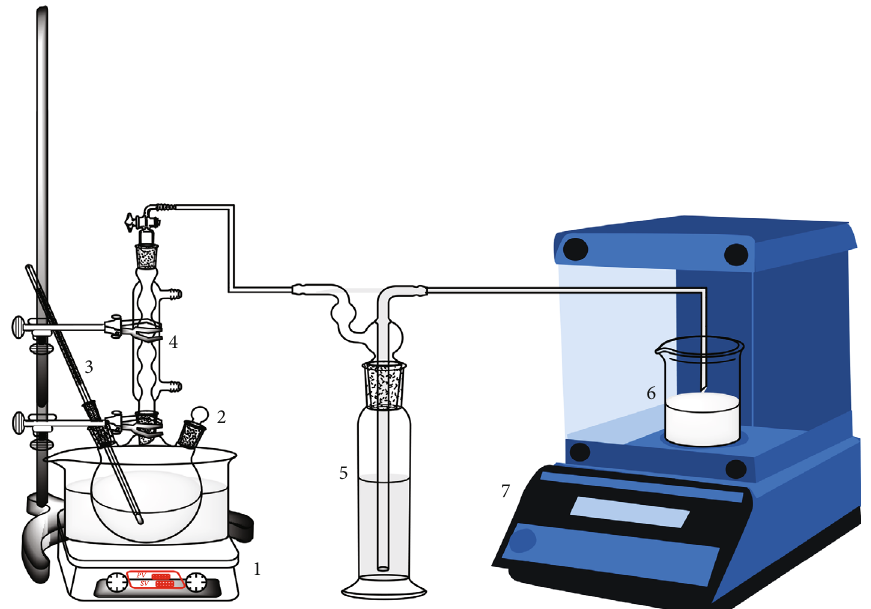
Figure 1: Hydrolysis unit. ((1) water bath, (2) three-necked fl ask, (3) thermometer, (4) condenser, (5) gas washing bottle, (6) beaker, and (7) analytical